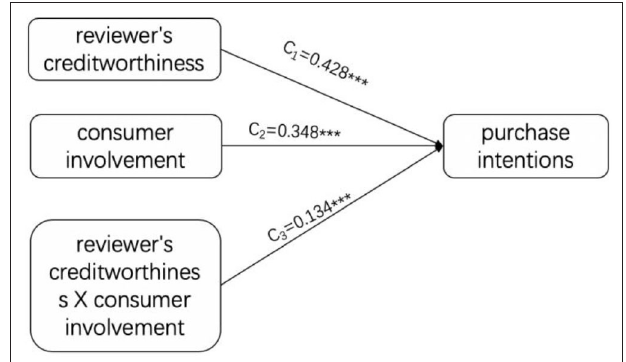
FIGURE 2 | Test of the adjustment effect of consumer involvement.